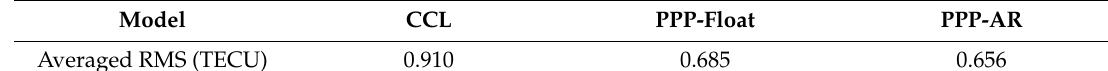
Figure 6. The absolute residuals’ distribution of ionospheric observables from reference stations in the global area on 10 April 2017 (DOY 100, 2017) for the CCL (green), PPP-float (red), and PPP-AR (blue) methods. Table 5. Averaged RMS of posteriori residuals of the CCL, PPP-float, and PPP-AR methods from DOY 100 to 106, 2017.